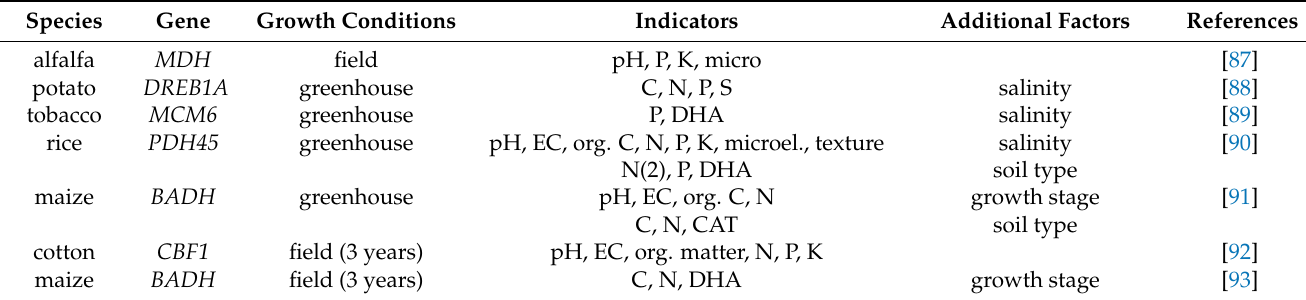
Table 4. Risk assessment of stress-tolerant transgenic plants on soil